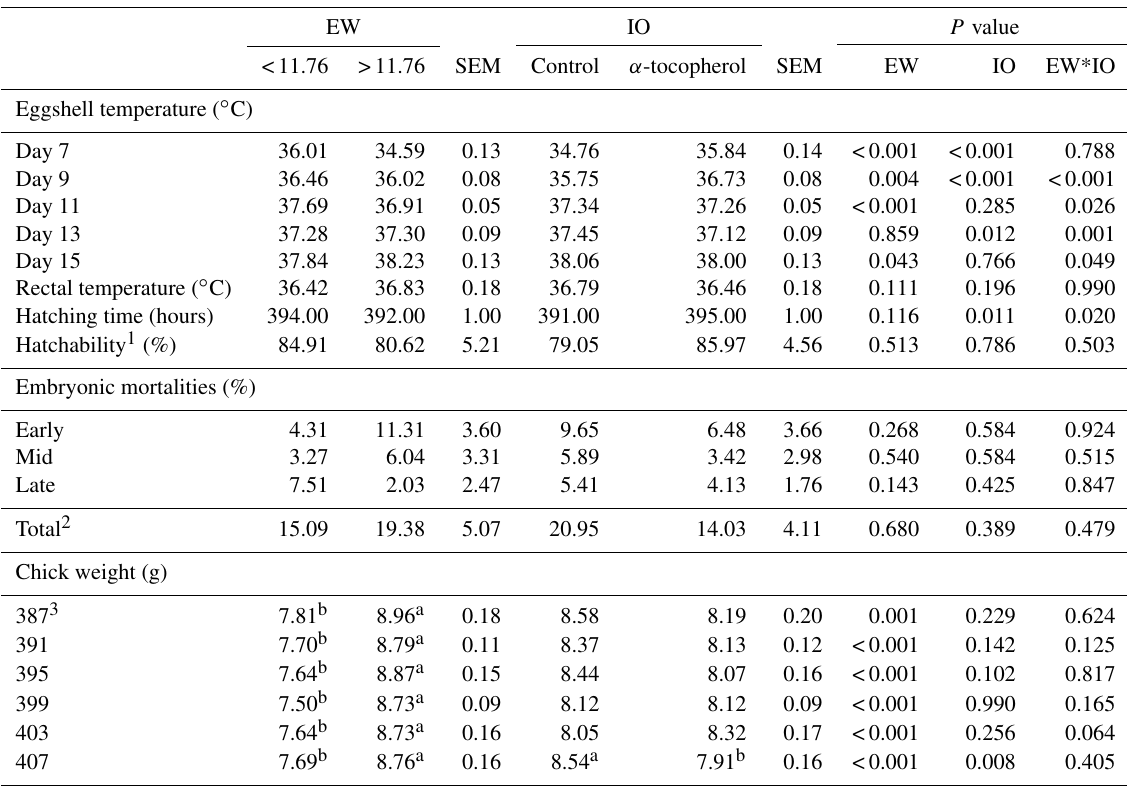
Table 2. The effects of egg weight and in ovo administration of α -tocopherol on eggshell temperature at days 7, 9, 11, 13 and 15 of incubation, rectal temperature, hatching time, hatchability, embryonic mortalities and chick weight in the quail. EW